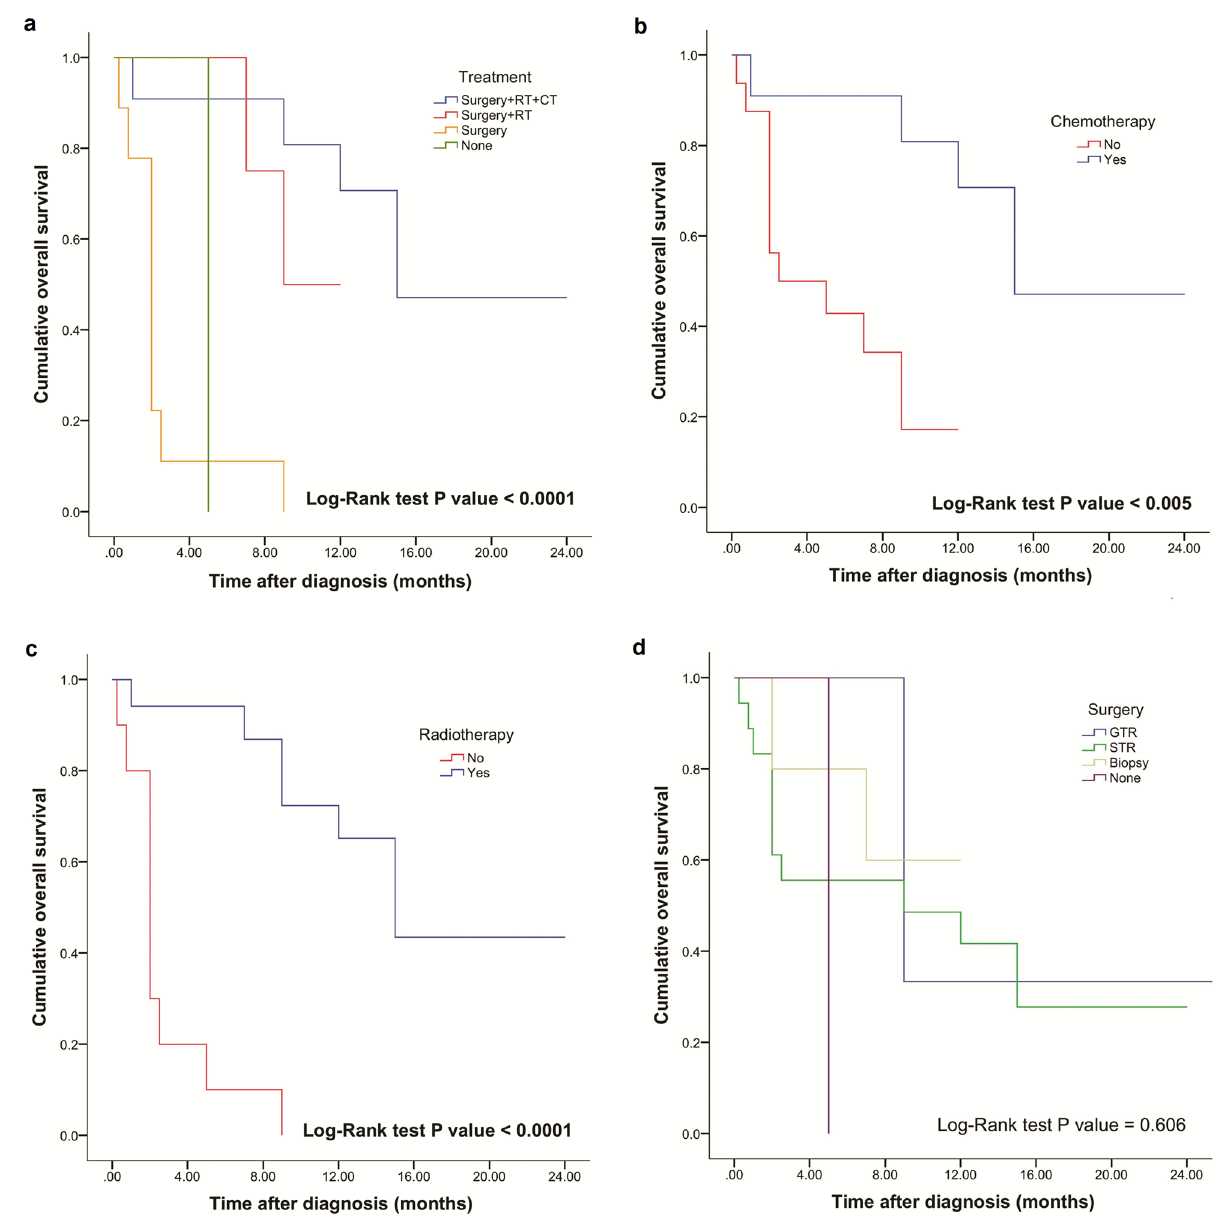
Figure 2. Comparison of OS based on treatment modalities ( a ) with patient subgroups receiving surgery and complete adjuvant treatment (n = 13), surgery and adjuvant radiation treatment (n = 7), surgery alone (n = 9), and no treatment (n = 1). Kaplan–Meier plot of chemotherapy (n = 13), and no adjuvant chemotherapy (n = 17) subgroups ( b ), and patients with CPA glioblastoma receiving radiation treatment (n = 20), and with no